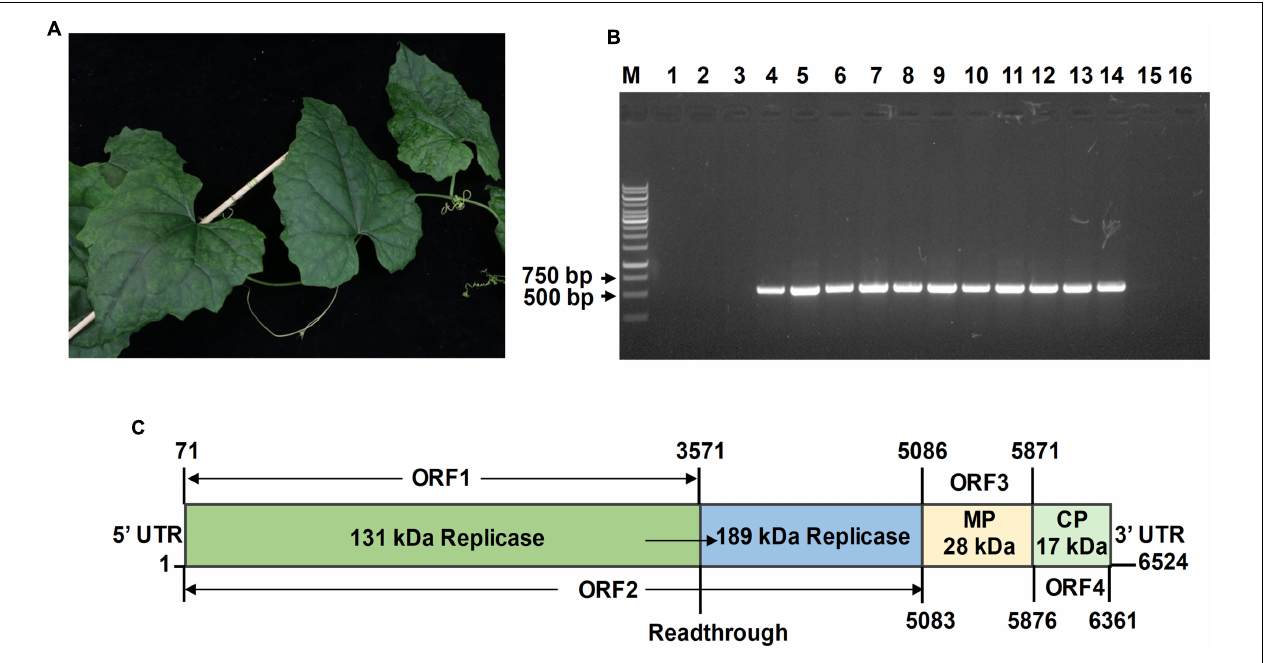
FIGURE 1 | Features of Trichosanthes mottle mosaic virus (TrMMV). (A) Leaf mottling and mosaic symptoms associated with the diseased Trichosanthes kirilowii . (B) Detection of TrMMV by RT-PCR with TrMMV-specific primers (TrMMV-F/TrMMV-R, Supplementary Table 1 ). Lane M, GeneRuler 1 kb DNA ladders (Thermo); lane 1–14, cDNA extracted from the 14 T. kirilowii samples were used as templates for RT-PCR; lane 15 and 16, cDNA extracted from virus-free T. kirilowii plant and ddH 2 O were used as the negative controls, respectively. (C) Genomic organization of TrMMV. The numbers indicate the position of nucleotides. The protein products encoded by each open reading frame (ORF) are listed. The 189-kDa replicase is encoded by ORF2 via a read-through mechanism. MP, movement protein; CP, coat